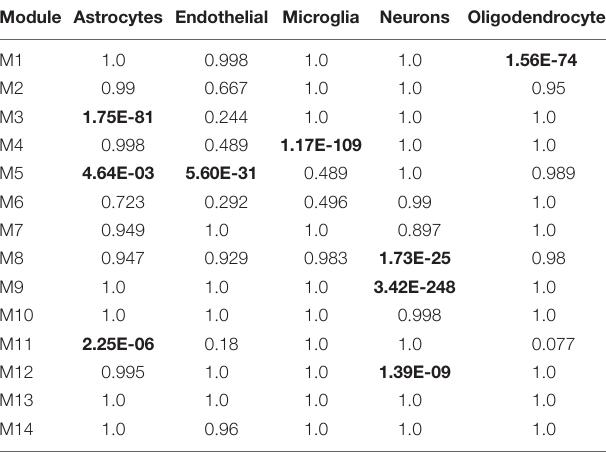
TABLE 1 | The overlap between cell-type specific genes and modules. Module Astrocytes Endothelial Microglia Neurons Oligodendrocytes